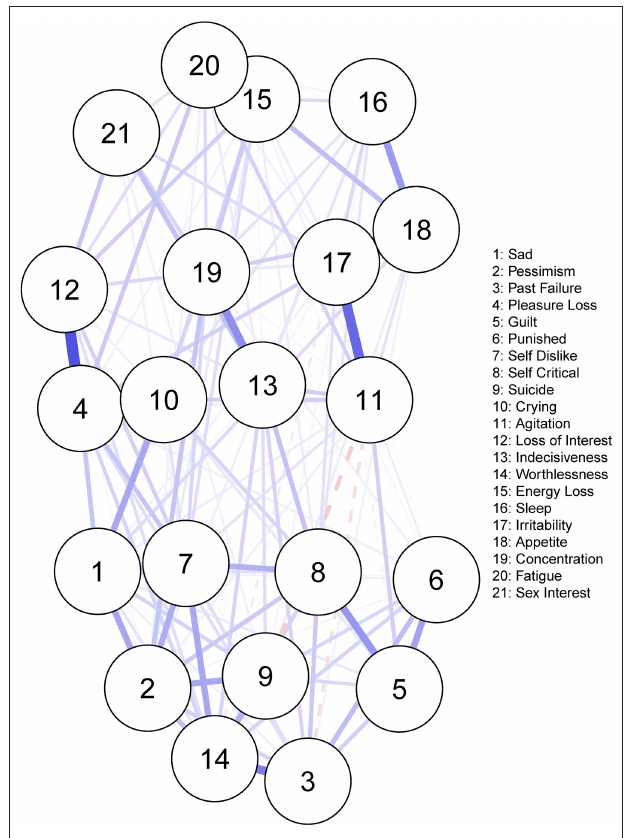
FIGURE 2 | Residual symptom network post-CBT, measured using the BDI-II. Blue edges indicate symptom activation, and red edges indicate symptom